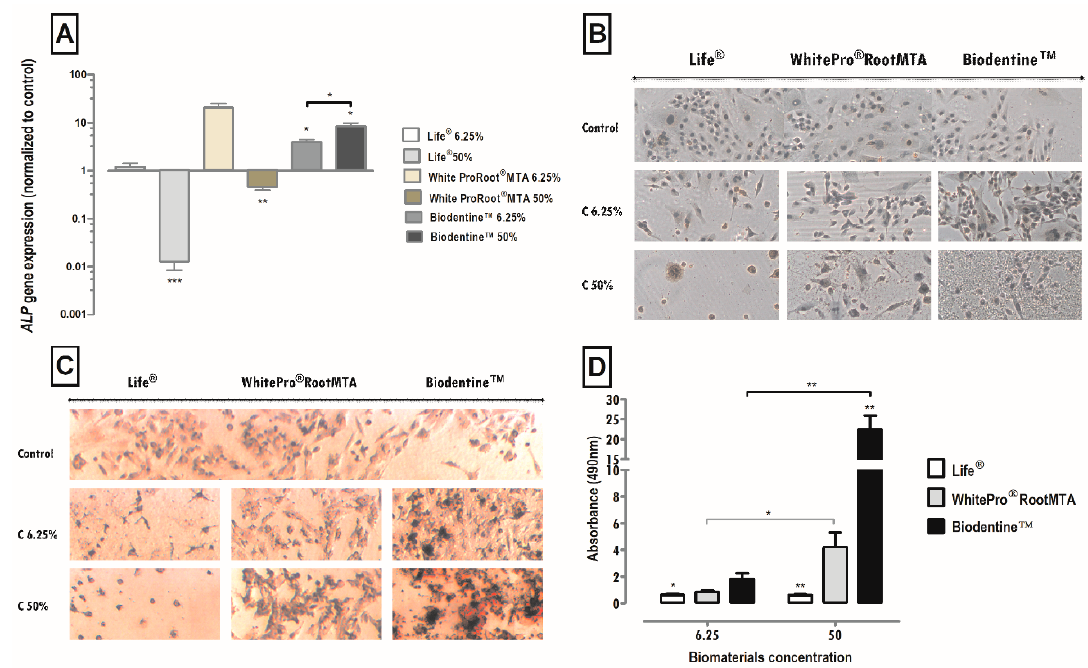
Figure 5. ( A ) Alkaline phosphatase gene expression by MDPC-23 cells treated with Life ® , WhiteProRoot ® MTA and Biodentine ™ after 96 h of exposure. The results represent the mean and standard error of four trials. ( B ) Images from cultured MDPC-23 cell lines labeled by immunocytochemistry for the detection of DSP expression when subjected to treatment with Life ® , WhiteProRoot ® MTA and Biodentine ™ at concentrations of 50% and 6.25% after 96 h of incubation. ( C ) Images from cultured MDPC-23 cells stained with Alizarin Red S stain when treated with Life ® , White ProRoot ® MTA and Biodentine ™ biomaterials at concentrations of 50% and 6.25% after 120 h of incubation. All the photographs were obtained with a magnification of 100 × . These assays were performed in duplicate. ( D ) Formation of calcium deposits from MDPC-23 cells treated with Life ® , WhiteProRoot ® MTA and Biodentine ™ after 120 h of exposure. The results represent the mean and standard error of six trials and are the relationship between the absorbances obtained between the study condition and the control. For ( A , D ), significant differences are represented by *, where * means p < 0.05, ** means p < 0.01 and *** means p < 0.001.